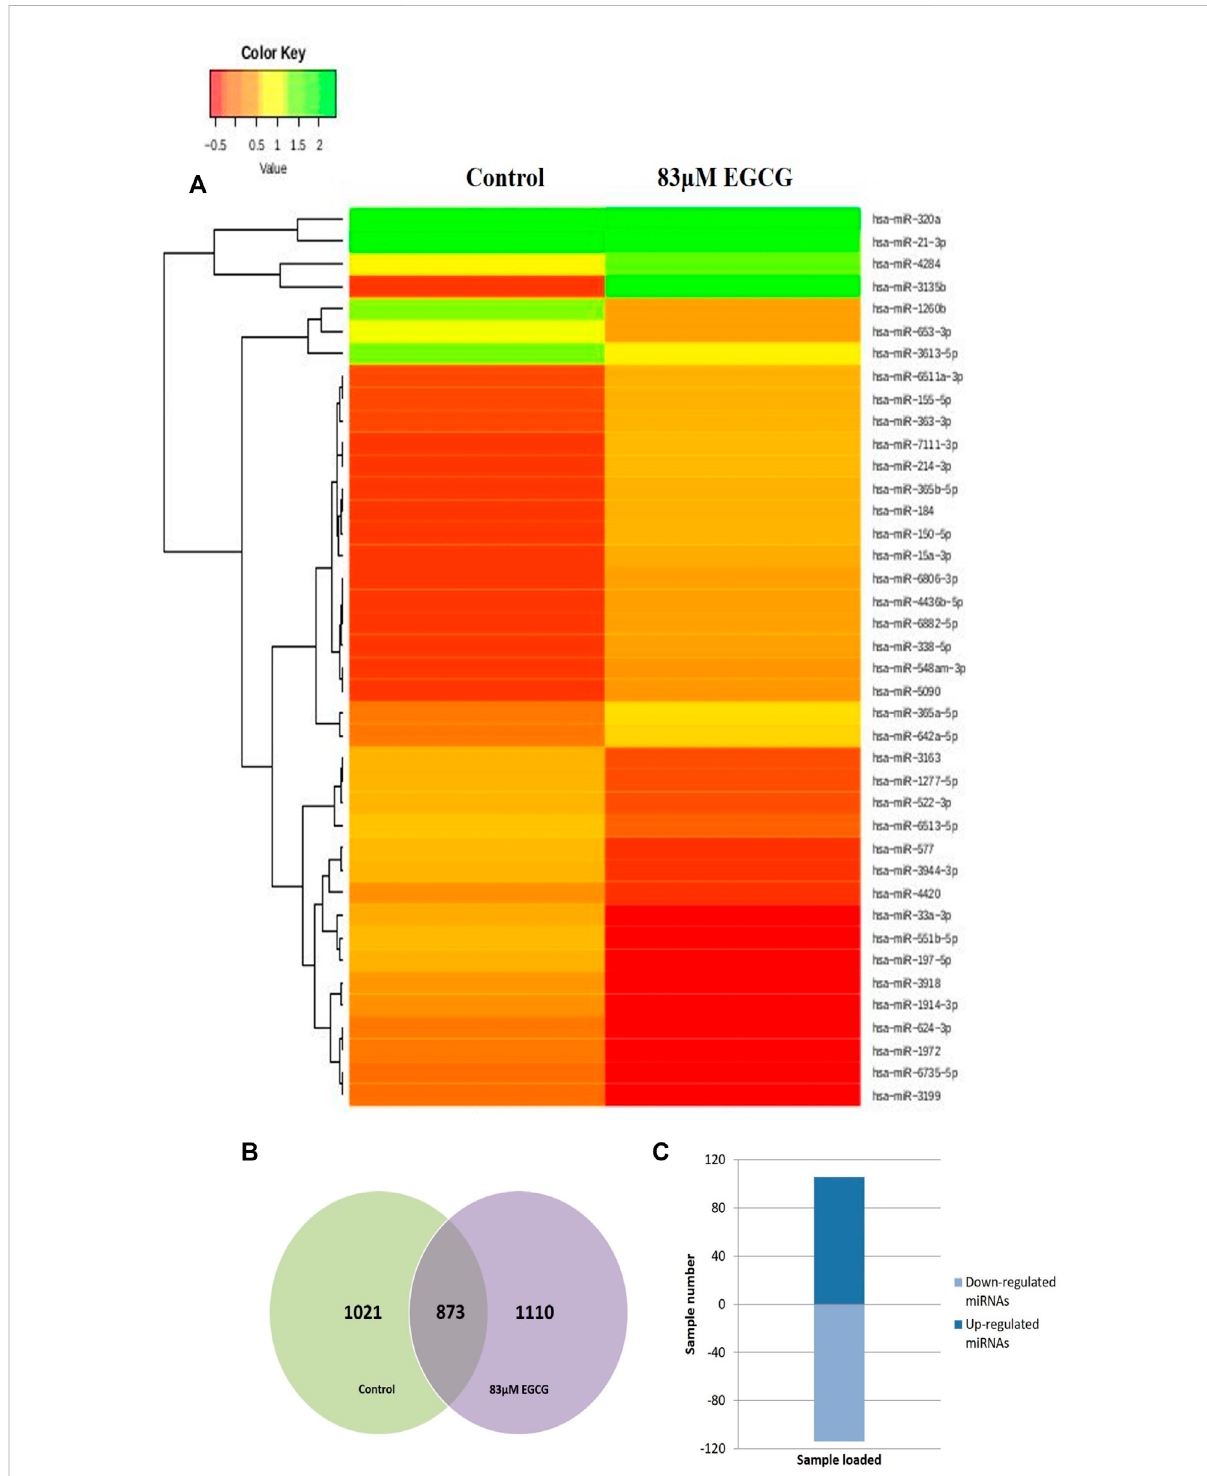
FIGURE 7 Dose-dependent known microRNA expression pro fi le. (A) Relative microRNA expression levels of top 20 up- and down-regulated known microRNAs in the untreated control vs. 24 h of 83 µM EGCG treatment; Color key-red: up-regulation, green: down-regulation, and yellow: neutral expression. (B) Venndiagramis depicting thenumbersofknownmicroRNAsinuntreated control and EGCG treatedsample; (C) Summarysetofup- and down-regulated known microRNAs exhibiting a change of expression after EGCG